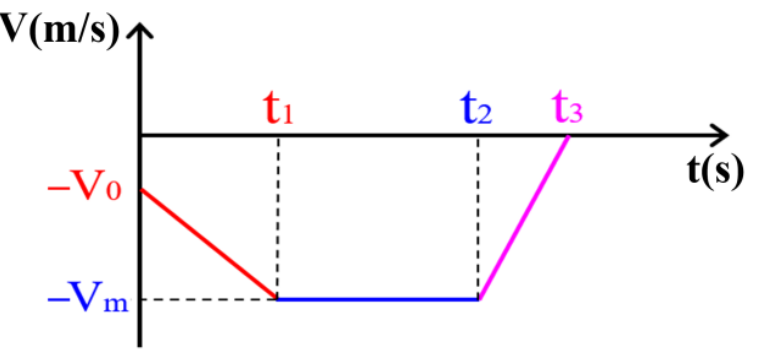
Figure 7. The one-dimensional docking reference trajectory of “acceleration—uniform velocity— deceleration” for the subsatellite.